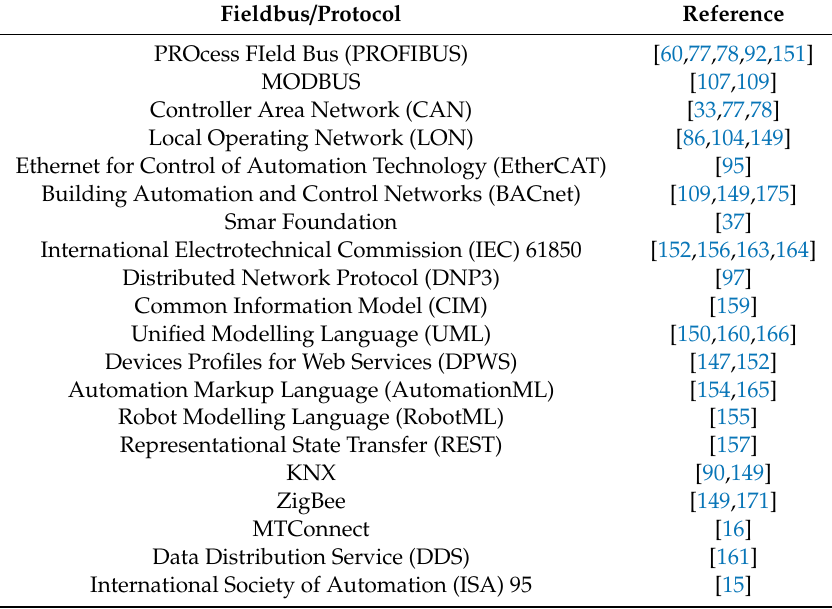
Table 7. Communication fieldbuses, protocols, and languages used with OPC.